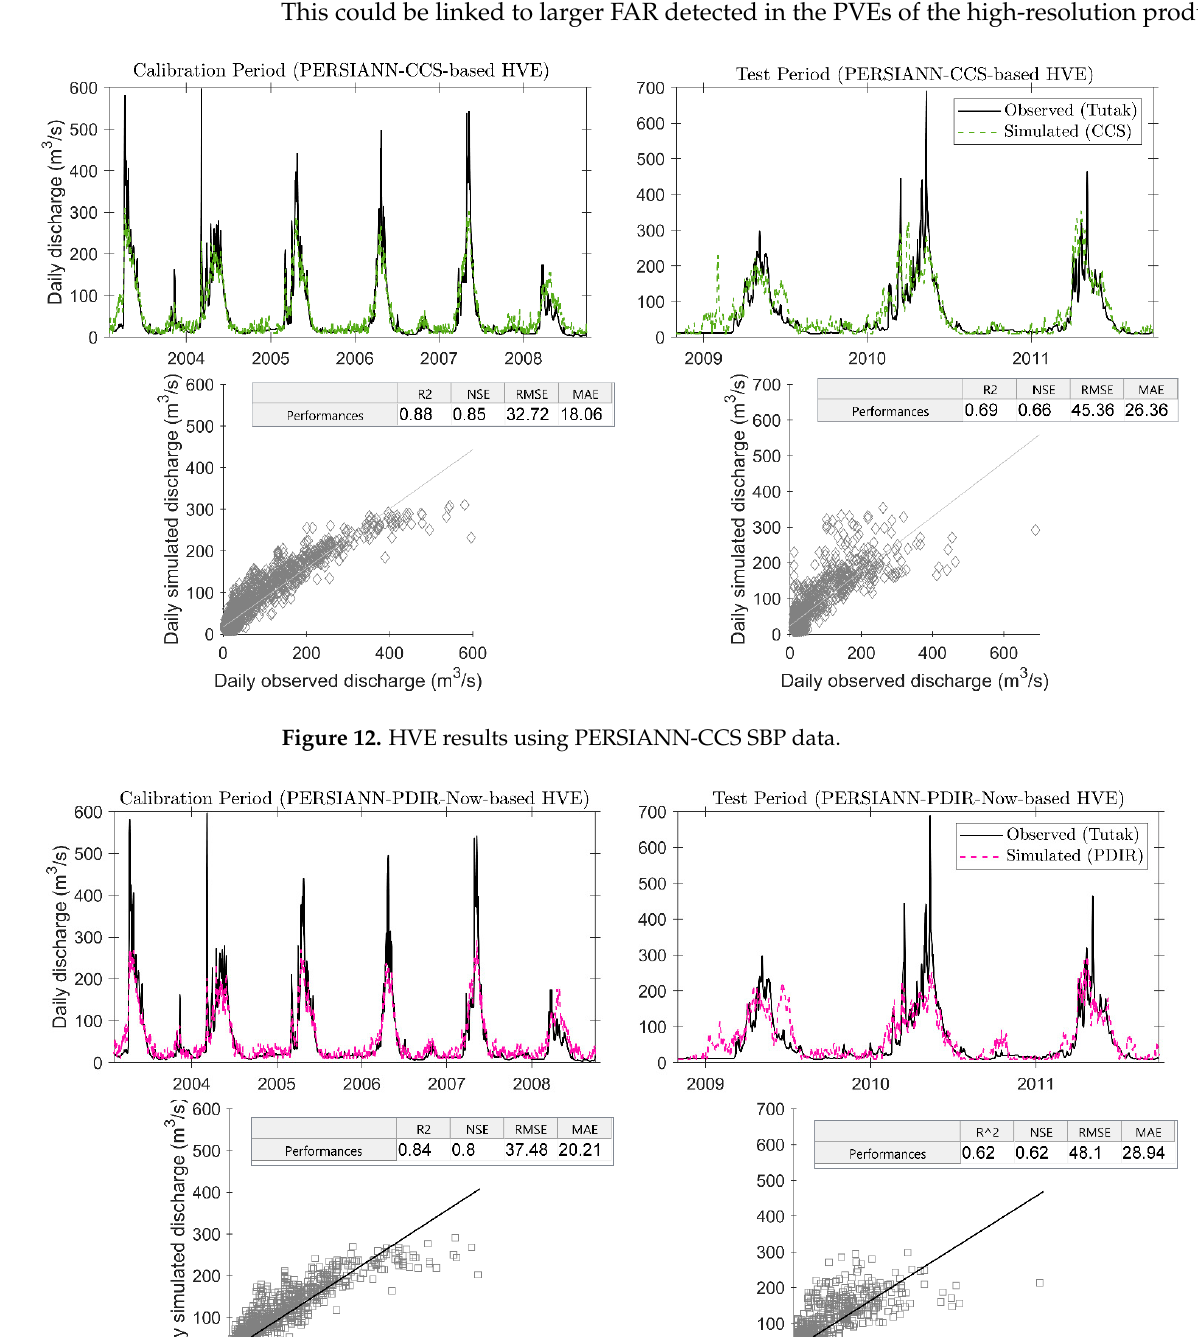
Figure 11. HVE results using PERSIANN-CDR SBP data.